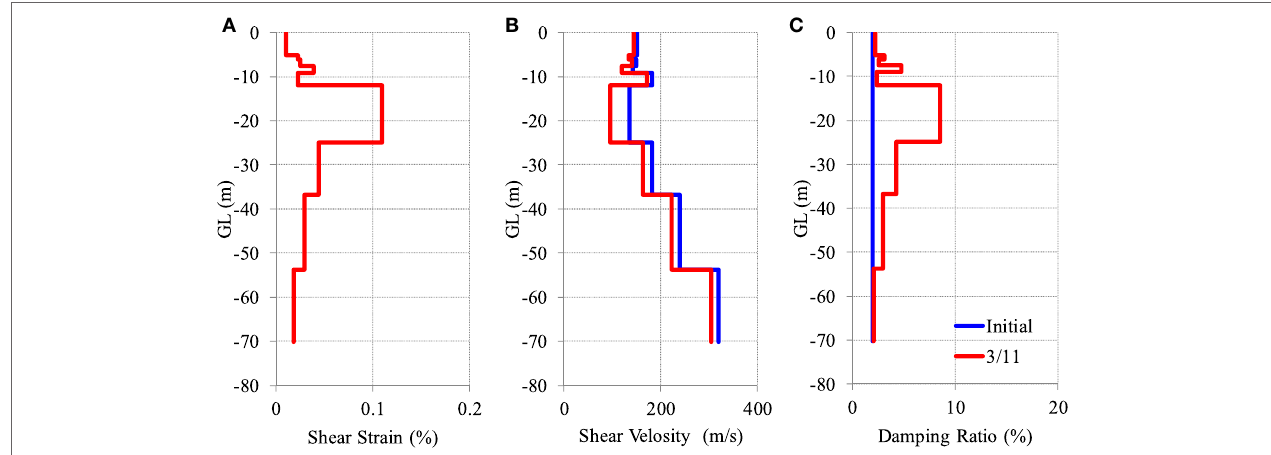
FigUre 4 | Results of the soil response analysis of the 3/11 main shock (average of N–S and E–W directions) showing (a) maximum shear strain, (B) shear wave velocity calculated from shear strain, and (c) damping